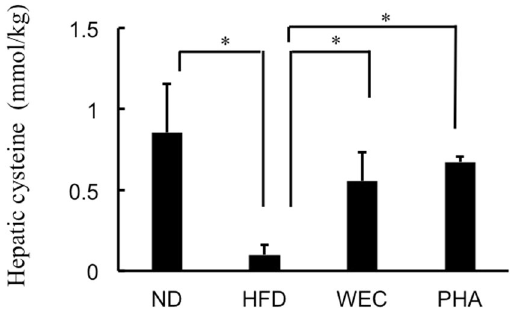
Fig. 6 The effects of WEC and PHA on hepatic cysteine levels. Hepatic levels of cysteine in the normal diet-fed (ND), high-fat diet- fed (HFD), Chlorella pyrenoidosa water extract-treated (WEC), and phenethylamine-treated (PHA) groups. Data are represented as mean ± standard deviation ( n = 6). The means were compared using analysis of variance, followed by Dunnett ’ s test. * p < 0.05 vs. HFD group.